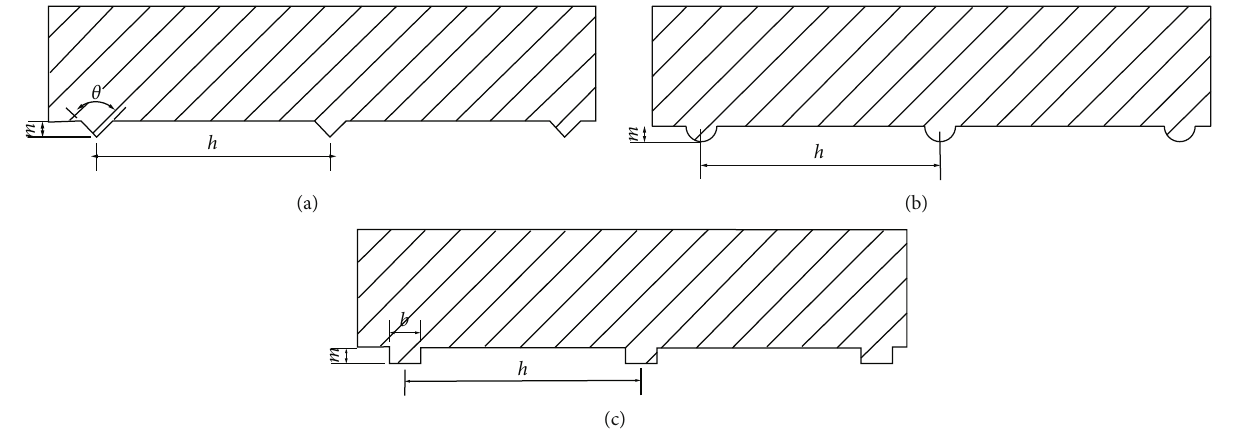
Figure 2: Schematic diagram of a bionic nonsmooth surface structure.